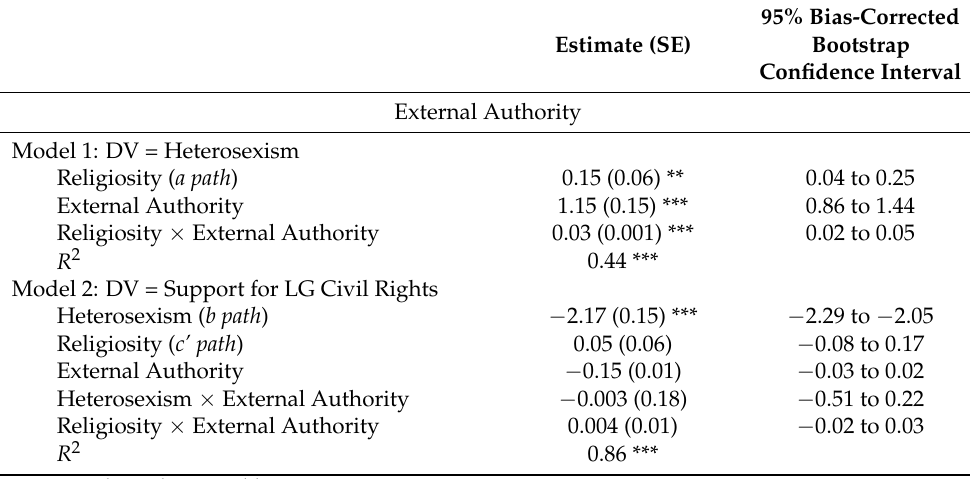
Table 2. Moderated Mediation Model Summary with External